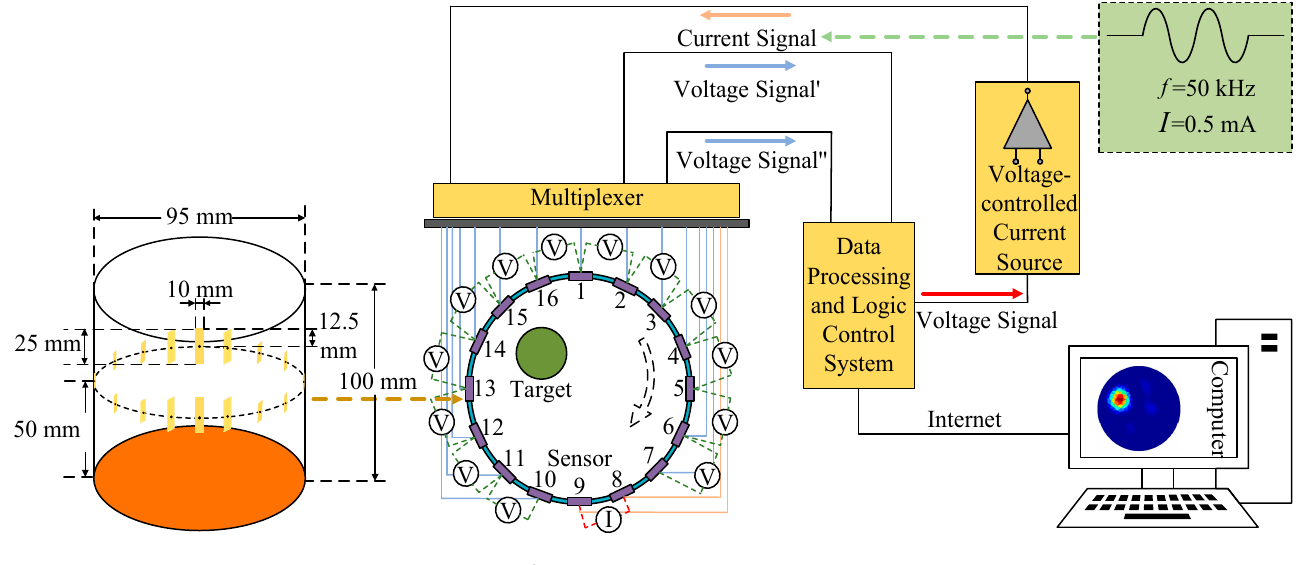
Figure 1. Diagram of EIT system.